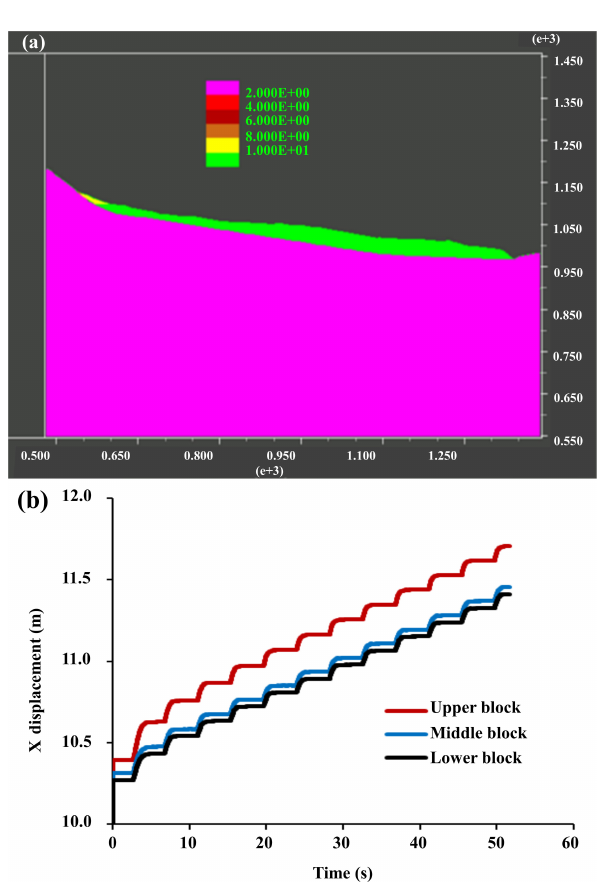
Figure 12. Plots of blocks (a) and displacements (b) as given in the UDEC output for run 13 (see Fig. S1b: using a cohesion of 0.01MPa and a seismic shaking of